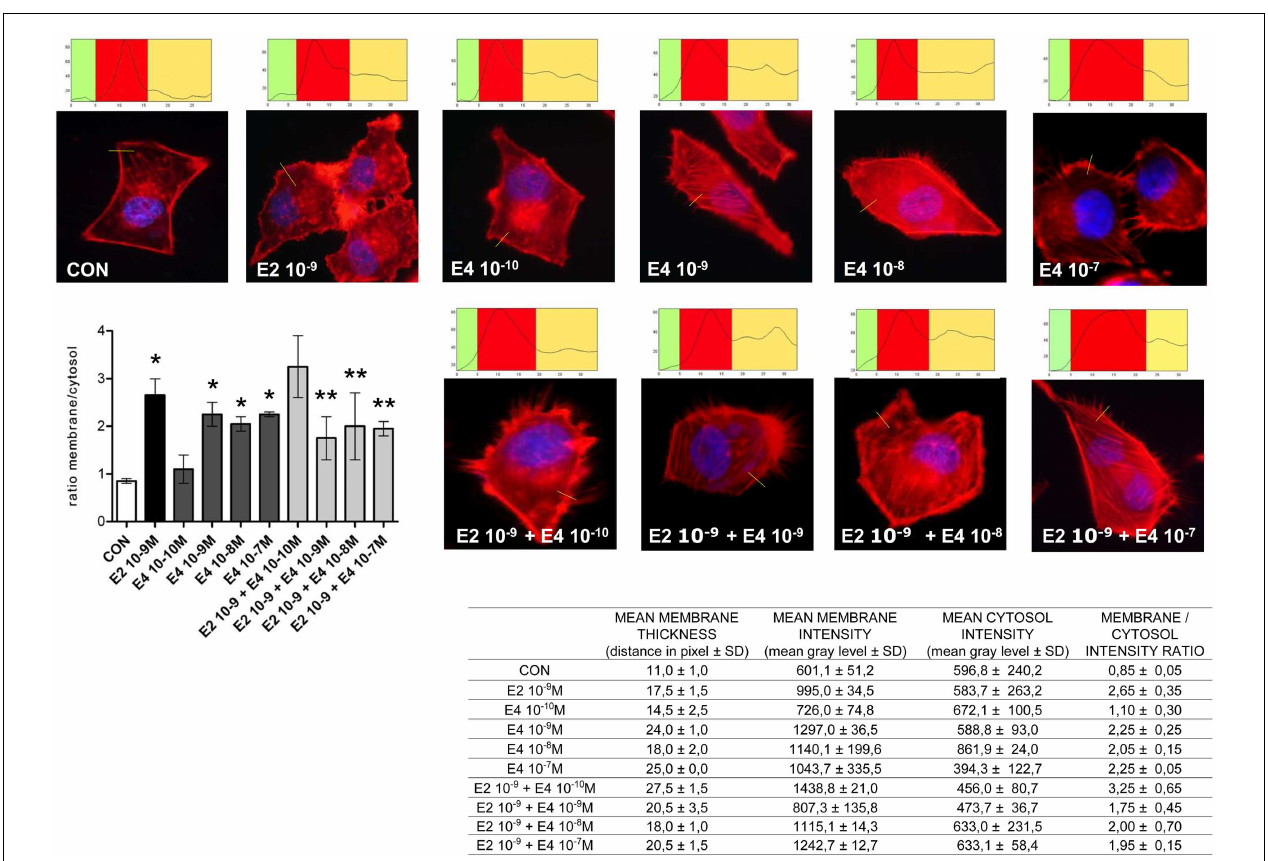
triplicate experiments.The box on top of the cells display sample areas of measurement (one per cell, indicated as the yellow line), showing the intensity of the signal throughout the measure.The results in the table are derived from the sampling of five areas of the cell membrane from 50 different random cells.The areas of minimum and maximum cell membrane thickness were always included.The results are the mean ± SD of the measurements.The graph plots the membrane/cytosol actin intensity ratio. * p < 0.05 vs. control. ** p < 0.05 vs.